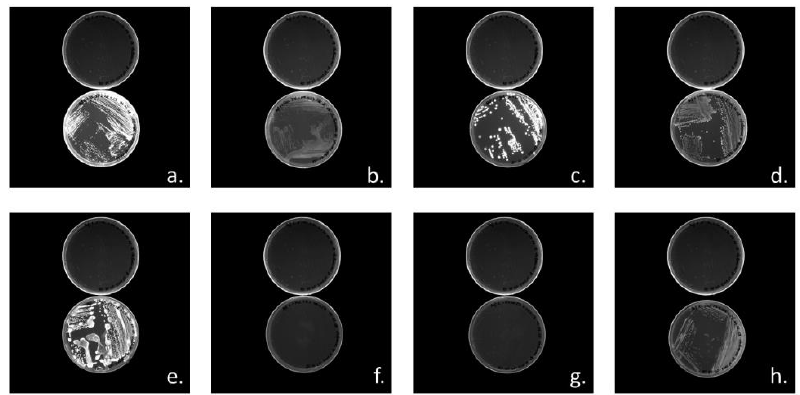
Figure 4. Nile Red agar plates screening with Halomonas sp. SF2003 using 2% (w/v) of different carbon substrates. Bacterial growth was evaluated under white light by the presence, or no, of colonies. PHA production was evaluated under Ultra-Violet light (UV-light) by fluorescence emission from colonies; positive results appear as “white” colonies showing their fluorescence. The positive control (medium without addition of carbon substrates) is the upper plate in ( a ) to Figure. ( a ). (D)-Glucose, ( b ). (D)-Fructose, ( c ). (D)-Galactose, ( d ). (D)-Mannose, ( e ). (D)-Maltose, ( f ). (D)-Melibiose, ( g ). (L)-Rhamnose, and ( h ). (D)-Sucrose. Observations under UV-lights performed with transillumination. Table 2. Growth and PHA accumulation in Halomonas sp. SF2003 using different carbon sources. Carbon Source Growth PHA accumulation